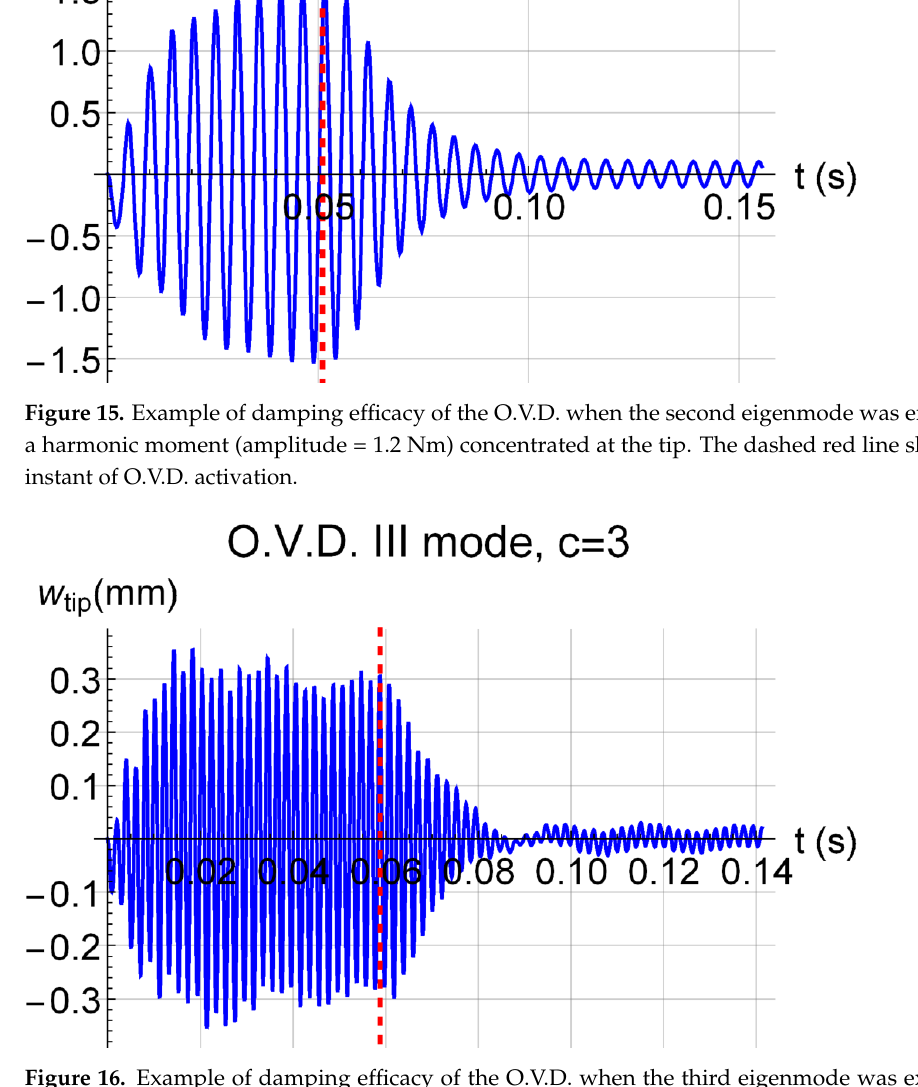
Figure 16. Example of damping efficacy of the O.V.D. when the third eigenmode was excited by a harmonic moment (amplitude = 0.9 Nm) concentrated at the tip. The dashed red line shows the instant of O.V.D.